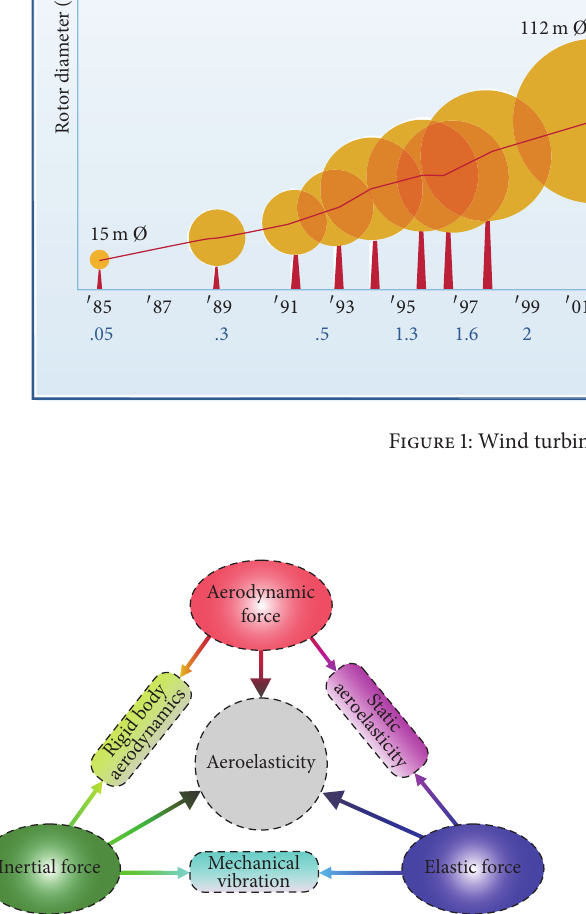
Figure 2: Collar’s triangle: interaction of different forces.